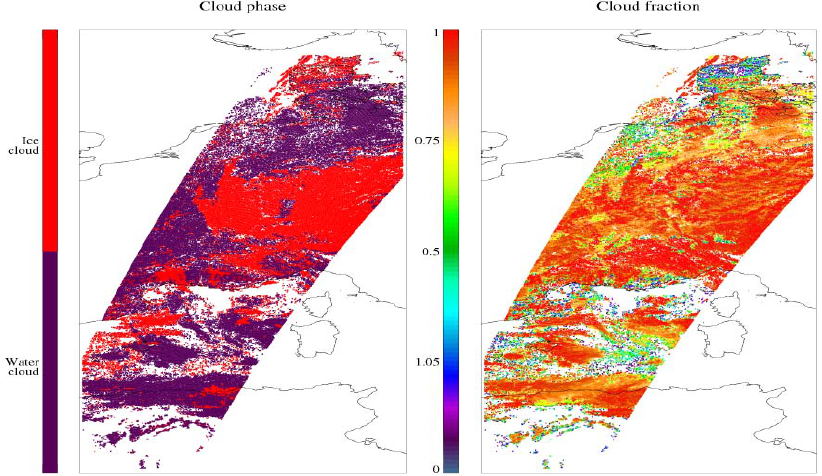
Fig. 8. Cloud phase and Cloud fraction for the image of Fig. 6, 10 November